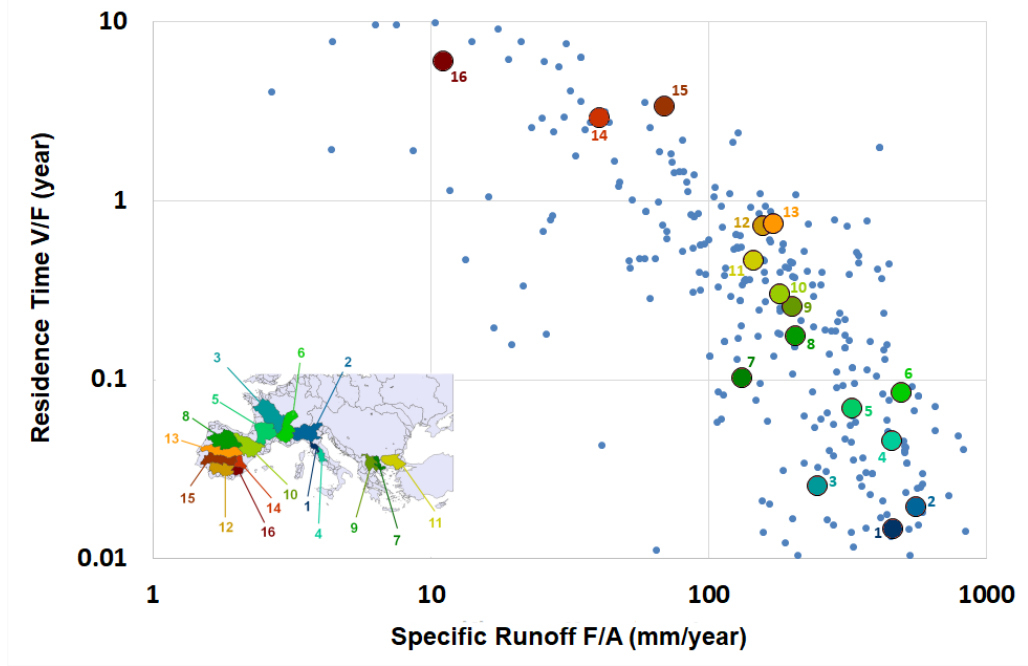
Figure 4. Relation between Specific Runoff (F/A) and reservoir Residence Time (V/F) for Hydro1K basins in Southern Europe. The 16 basins under study are highlighted using the same color coding and numbering as in Figure 1.